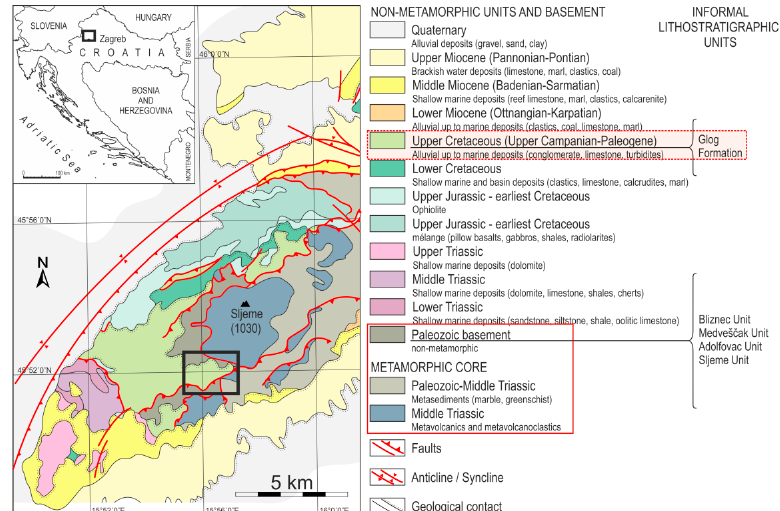
Figure 1. Geographic location and geological map of the study area (after [18], modified). Position of the studied sections is marked by a black rectangle on the map. Studied deposits belong to the Upper Cretaceous informal Glog Formation (sensu [11]) (highlighted in the Legend). Clasts are mostly composed of Paleozoic to Middle Triassic metasediments, rarely of metavolcanics, from the metamorphic core and Paleozoic non–metamorphic rocks (red rectangle on the Legend).